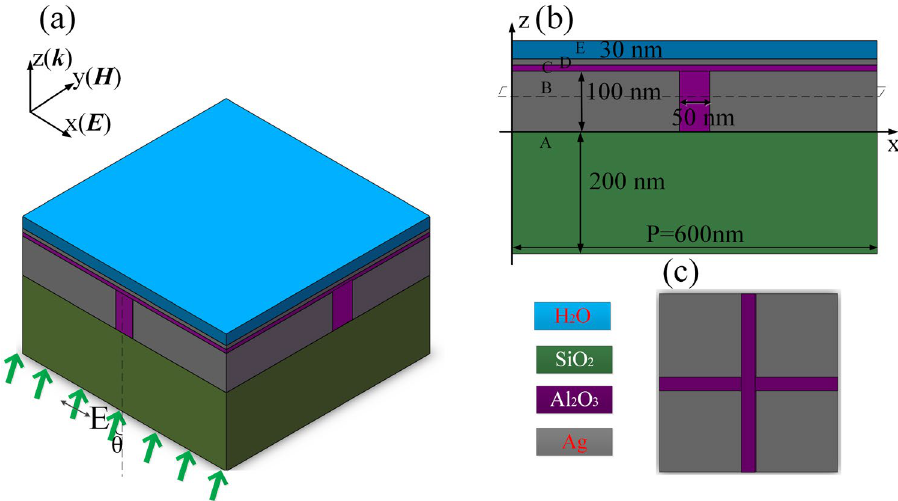
Figure 1. The schematic diagram of the meta-sandwich structure. ( a ) Perspective view and ( b ) cross sectional view, ( c ) top view of Layer B , marked as the dashed rectangle in ( b